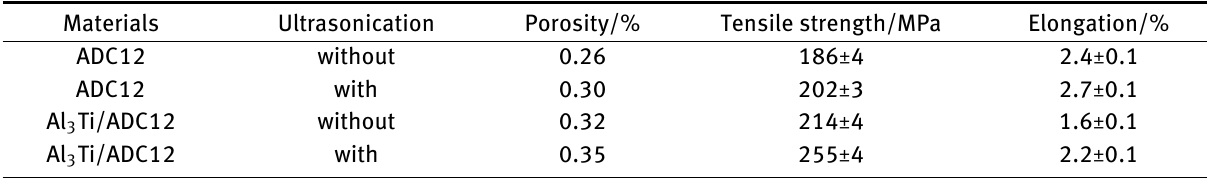
Table 3: Mechanical properties of the matrix and composites